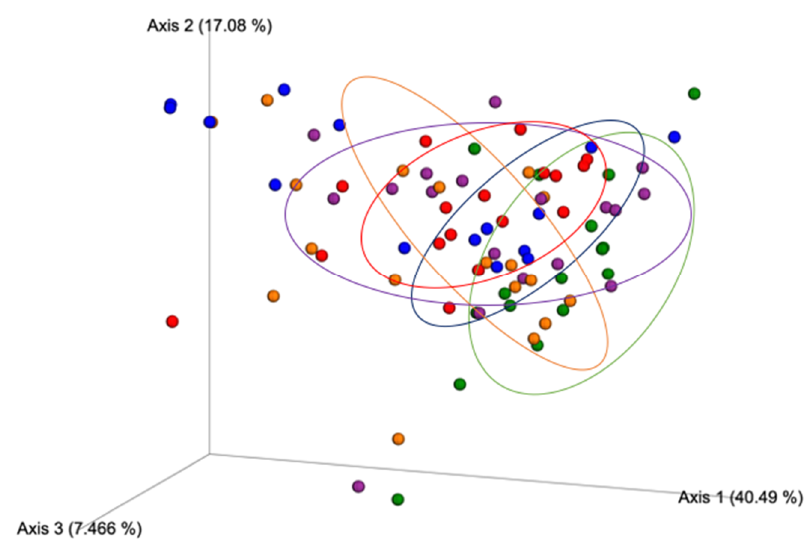
Figure 6. Beta diversity PCoA plot of between-group distances using weighted UniFrac distance matrix values. Treatment groups are as follows: control, red; high-fat, high-sugar diet (HFD), blue; HFD + genistein (Gen), purple; HFD + exercise (Exe), orange; HFD + Exe + Gen, green. Significant group differences ( p < 0.05) after Benjamini–Hochberg correction for multiple comparisons were observed for all pairwise treatment comparisons.